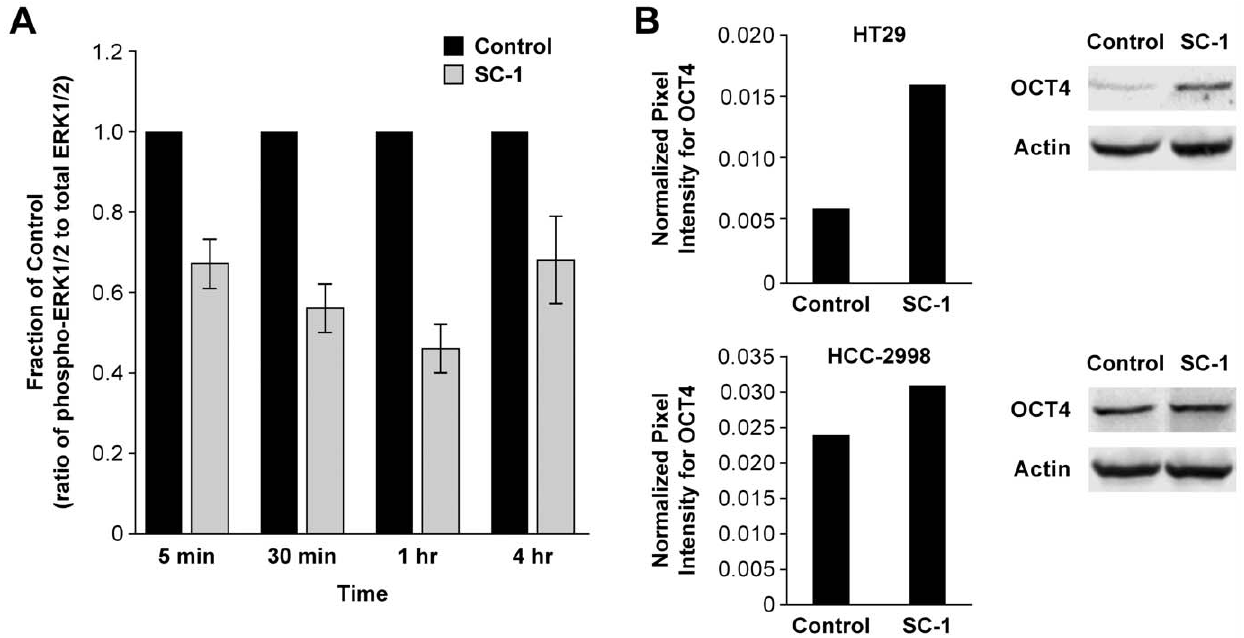
Figure 3. Effect of SC-1 on Protein Expression Levels of phospho-ERK1/2, and OCT4 in Colon Tumor Lines. Colon tumor lines were treated with SC-1 (0.1 m M), harvested, lysed, and probed for the proteins of interest following electrophoresis in SDS-PAGE gels at the indicated time points. A. In the SC-1 treated HT29 tumor line, phospho-ERK1/2/total ERK1/2 protein levels were decreased to 67 6 0.06% of control value at 5 min, 56 6 0.06% of control value at 30 min, and 46 6 0.06% of control value at 1 hr (n=3, p , 0.05). B. Increased OCT4 protein expression due to SC-1 was dependent on the tumor line. Representative experiments are shown for Figure S4A–B (n=2).